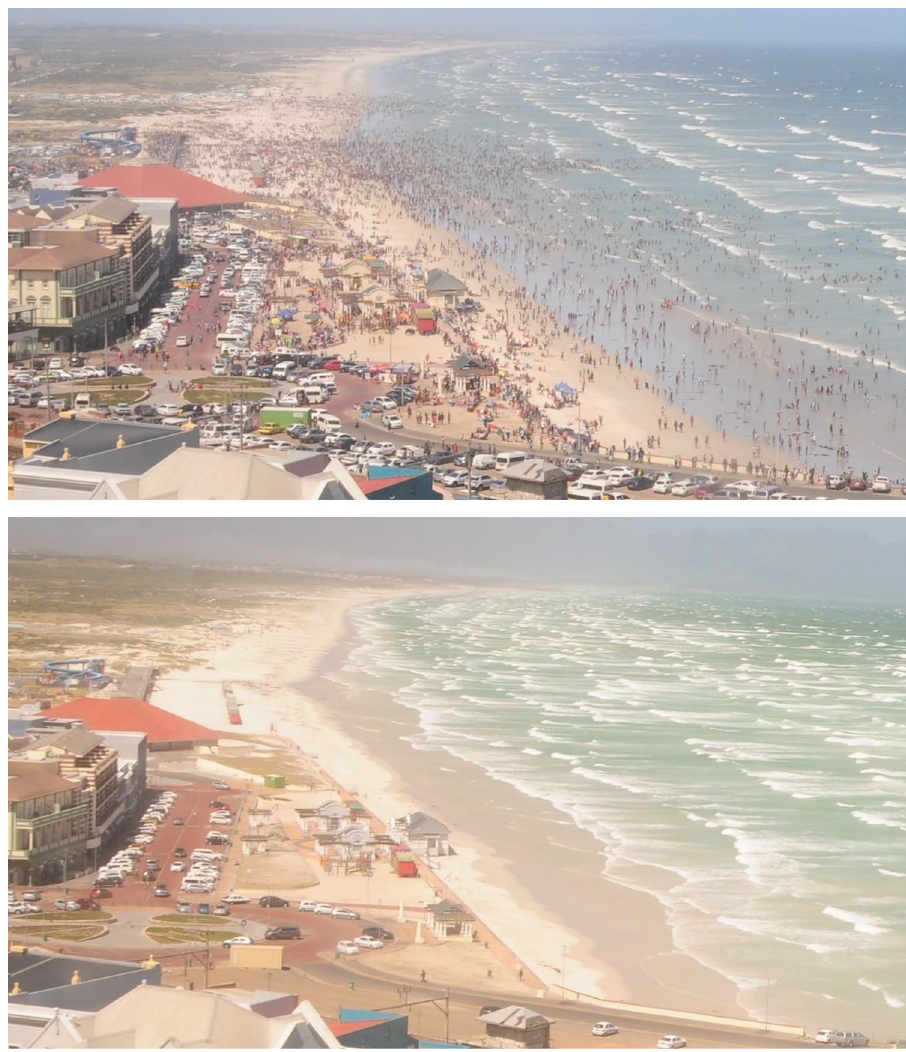
Figure 3. Photographs overlooking Muizenberg Beach on New Year’s Day (1st January;) in ( top ) 2020 (pre- COVID-19) and ( bottom ) 2021 (COVID-19 lockdown. Adjusted lockdown level 3 restrictions imposed to curb viral spread in South Africa’s 2nd wave of infections). Photographs taken at 14H43 courtesy of Associate Professor Coleen Moloney, University of Cape